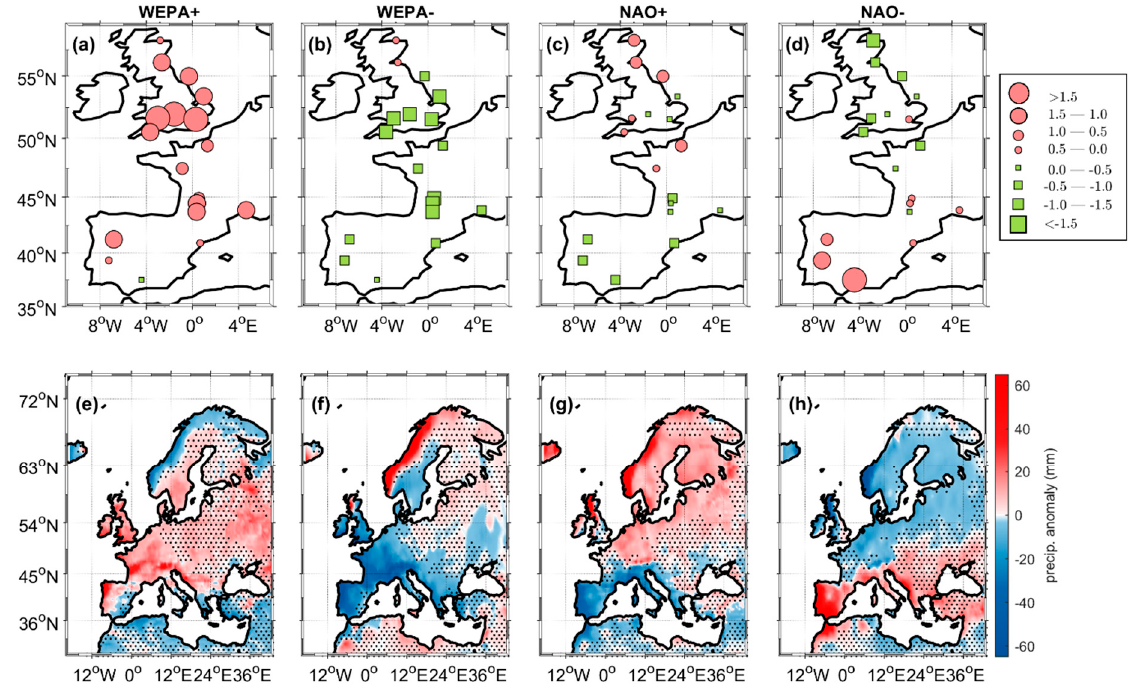
Figure 6. ( a – d ) Winter-averaged river discharge and ( e – h ) precipitation averaged over the five years of the strongest positive phases and of the strongest negative phases of the NAO and WEPA indices (details in the caption to Figure 3).